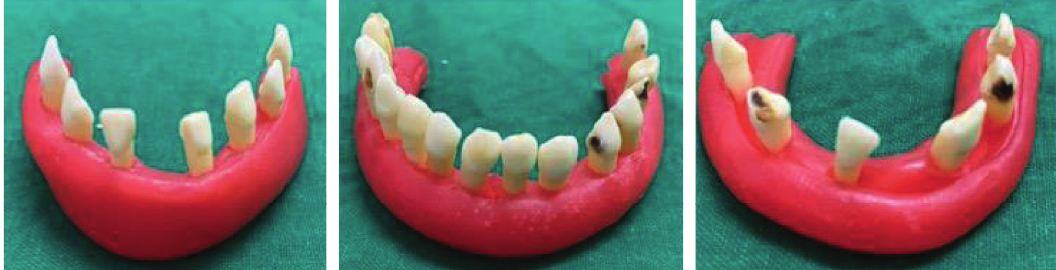
Figure 1: Sample teeth mounted on modelling wax in arch form.